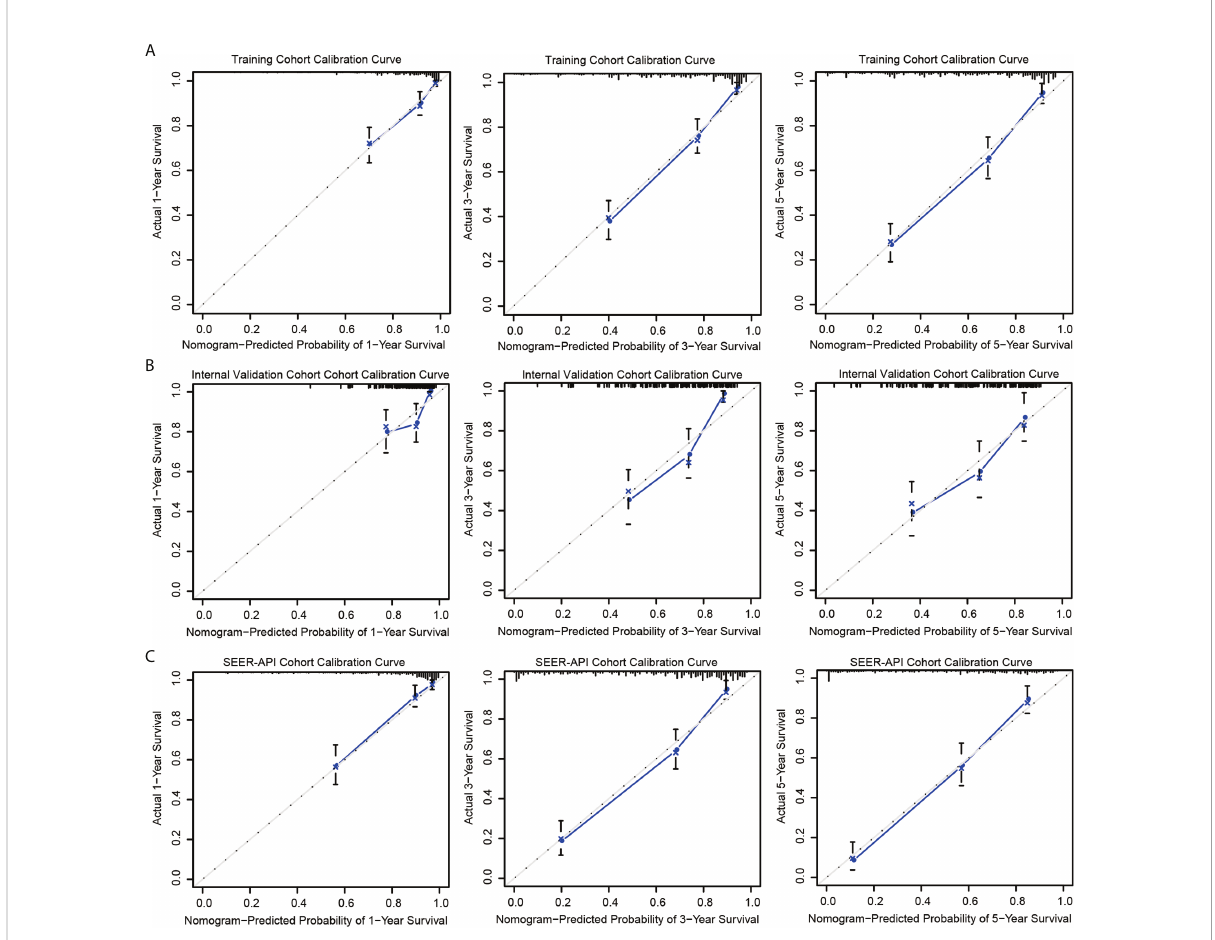
FIGURE 3 Calibration curves of model 2 nomogram. Calibration curves of the nomogram in the training set (A) , internal validation set (B) , and SEER-API external validation set (C) were plotted based on 1-, 3-, and 5-year CSS, respectively. The X-axis represents the model − predicted survival, and the Y − axis represents actual survival. The bar represents 95% CI measured by Kaplan – Meier analysis, and the dotted line represents the ideal reference